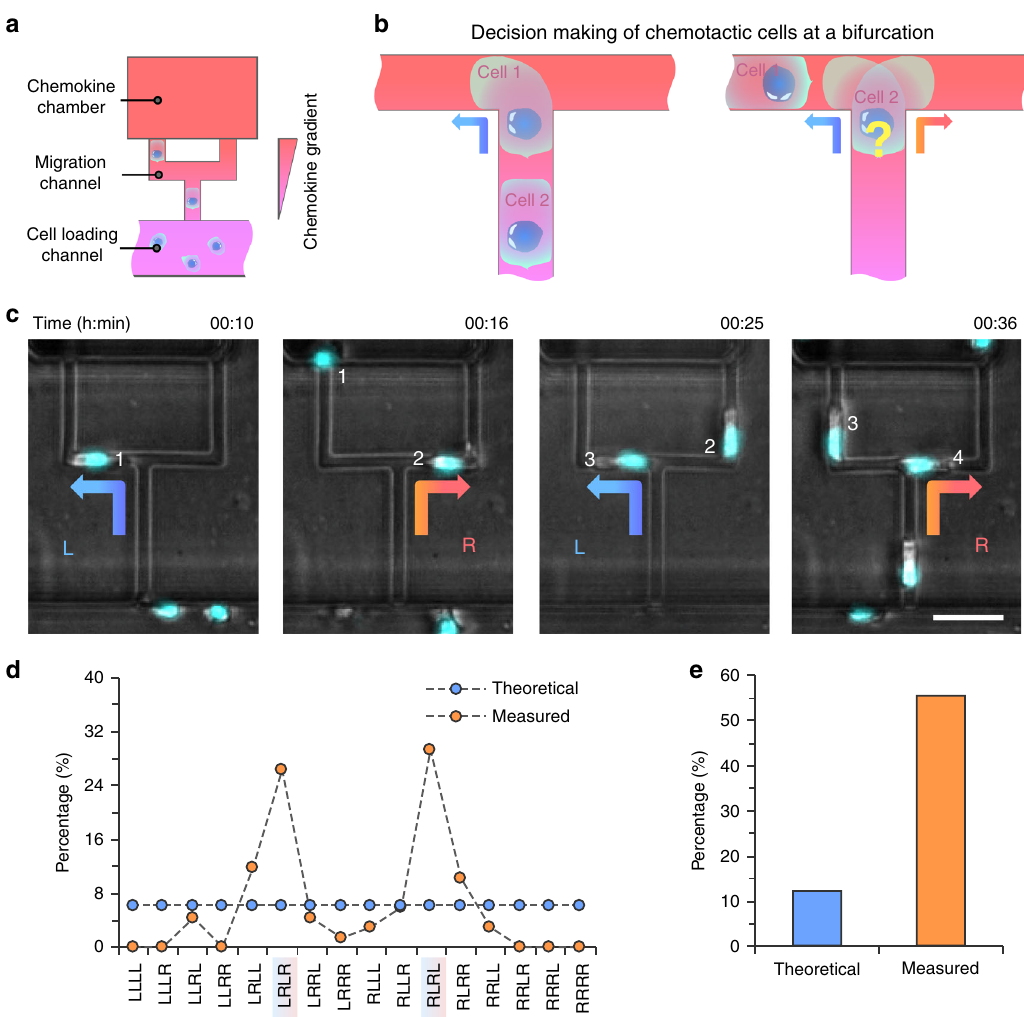
Fig. 2 Consecutive decision making of neutrophil squads at micro fl uidic bifurcations in vitro. a A schematic of the micro fl uidic system for studying the sequential migration patterns of groups of chemotactic neutrophils at bifurcations. b A schematic showing consecutive neutrophils migrating alternatively into the left and the right branches. c Time-lapse bright- fi eld microscopic images demonstrate that neutrophils in four-neutrophil squads enter alternate branches at bifurcations (left, right, left, right pattern). The scale bar is 25 µ m. d Theoretical and measured percentages of the 16 possible directional patterns for 4-neutrophil squads passing through bifurcations ( N = 4 donors, N = 68 4-neutrophil squads observed). e Theoretical and measured percentages of LRLR and RLRL